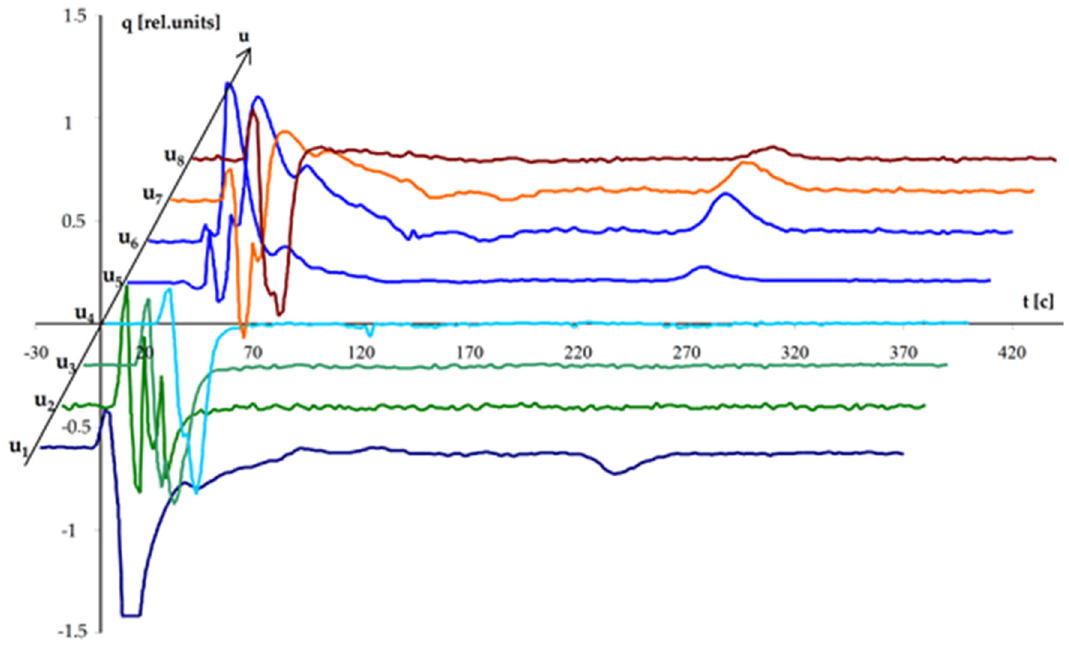
Figure 6. 3D chromatogram obtained with one coulometric cell operating in a cyclic mode (scan mode).